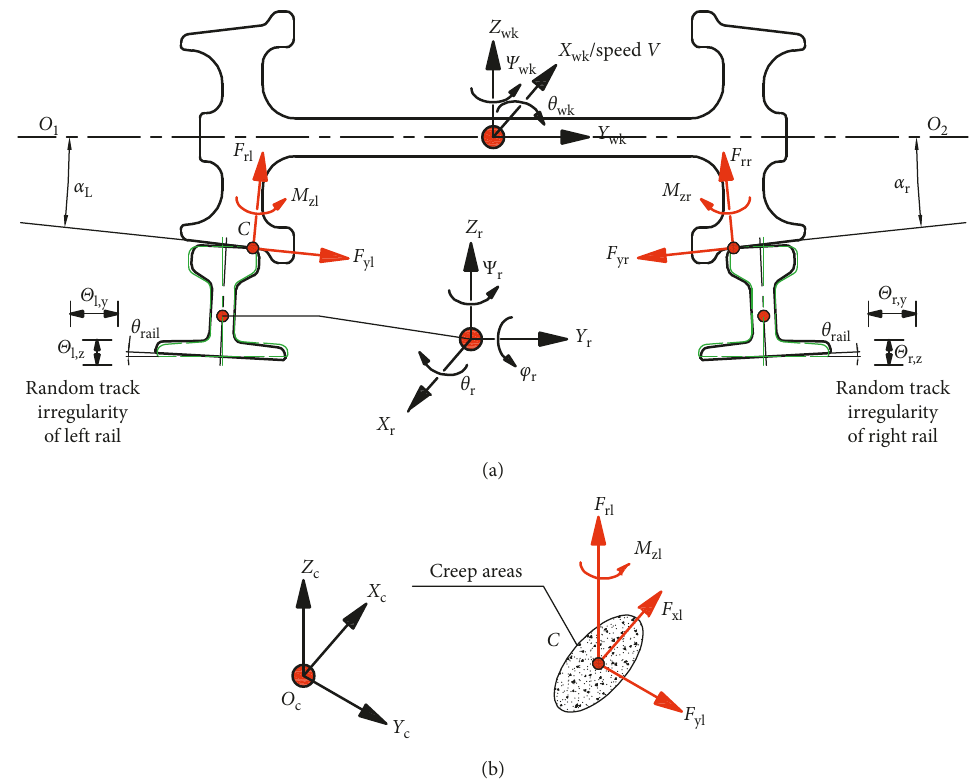
Figure 2: 3D random wheel/rail contact model: (a) front view; (b) elliptical contact spot at location of